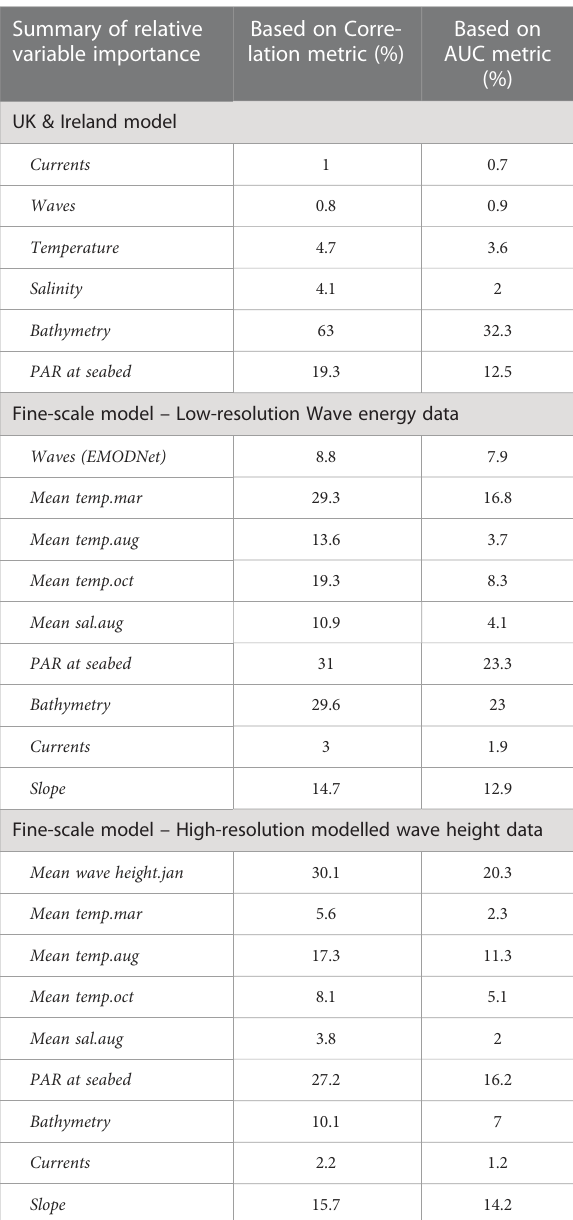
TABLE 1 Summary of the variable importance based on Correlation metric and AUC for each of the fi nal models, for the broadscale UK and Ireland model, the fi ne-scale model using lower resolution wave energy data (open source EMODNet) and fi ne-scale model using high resolution modelled wave height data